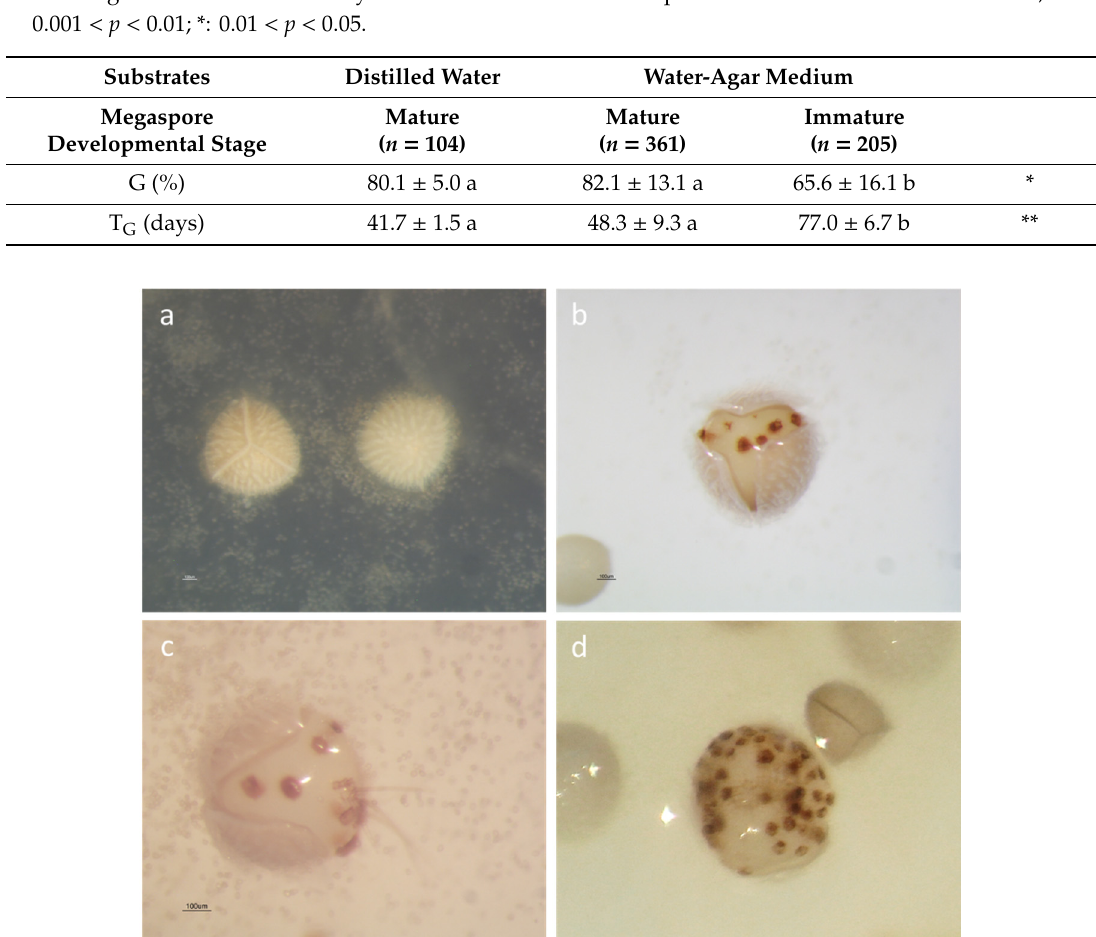
Figure 2. Spore germination of Isoëtes sabatina : ( a ) Initial adhesion between numerous microspores and megaspores; ( b ) endosporic germination of a megaspore split along the triradiate ridges, after two weeks of culture, with several archegonia (brown spots) developed on the exposed surface of the megagametophyte; ( c ) megagametophyte bearing some rhizoids, surrounded by multiple germinated microspores (empty), already split out to release spermatozoids; ( d ) non-fertilized megagametophyte with more than 50 archegonia 2 years and 10 months after sowing. Table 1. Germination percentage (G) and time for the first germination (T G ) of megaspores of Isoëtes sabatina in distilled water and water-agar cultures. All values are reported as mean ± SD; values followed by the same letter are not significantly different at the 5% level of probability, as determined by Dunn's test. Significance determined by the Kruskal–Wallis test is reported in the last column as follows, **: 0.001 < p < 0.01; *: 0.01 < p <